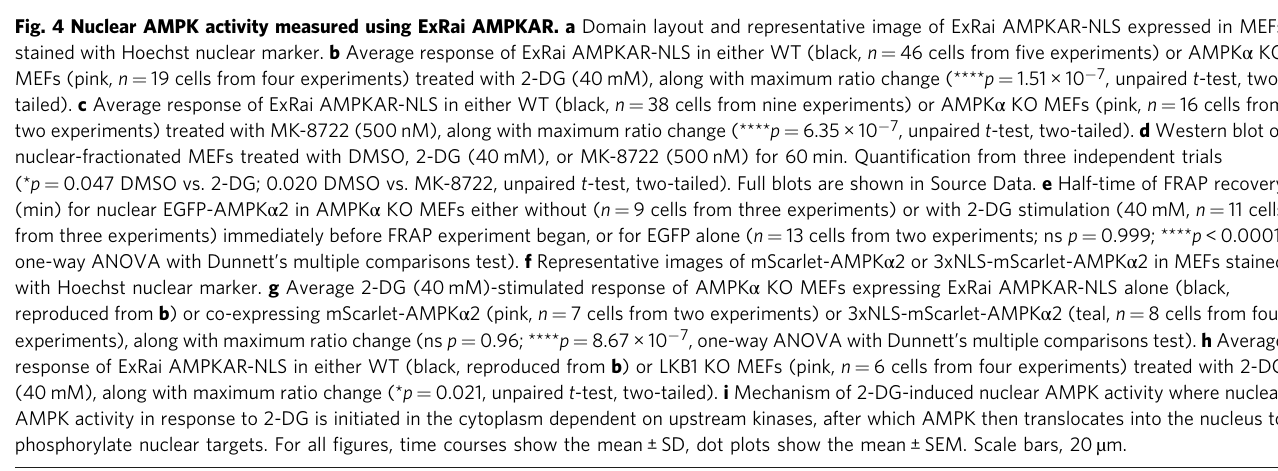
Fig. 4 Nuclear AMPK activity measured using ExRai AMPKAR. a Domain layout and representative image of ExRai AMPKAR-NLS expressed in MEFs stained with Hoechst nuclear marker. b Average response of ExRai AMPKAR-NLS in either WT (black, n = 46 cells from fi ve experiments) or AMPK α KO MEFs (pink, n = 19 cells from four experiments) treated with 2-DG (40 mM), along with maximum ratio change (**** p = 1.51 × 10 − 7 , unpaired t -test, two- tailed). c Average response of ExRai AMPKAR-NLS in either WT (black, n = 38 cells from nine experiments) or AMPK α KO MEFs (pink, n = 16 cells